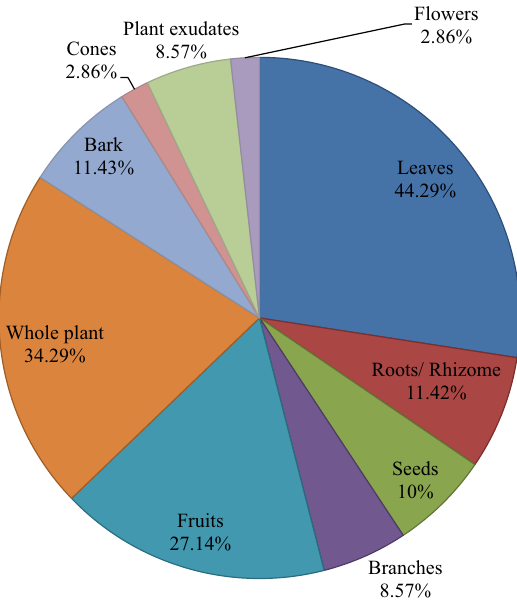
Figure 4: Percentages of plant parts